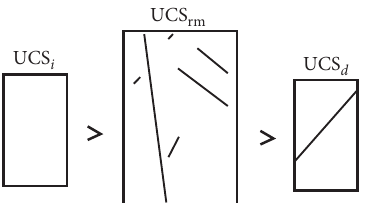
Figure 1: Concept of the UCS variability of rockmass specimens due to the different density and orientation of defects [3]. UCS i : intact rock UCS; UCS d : defected rock UCS; UCS rm : rockmass